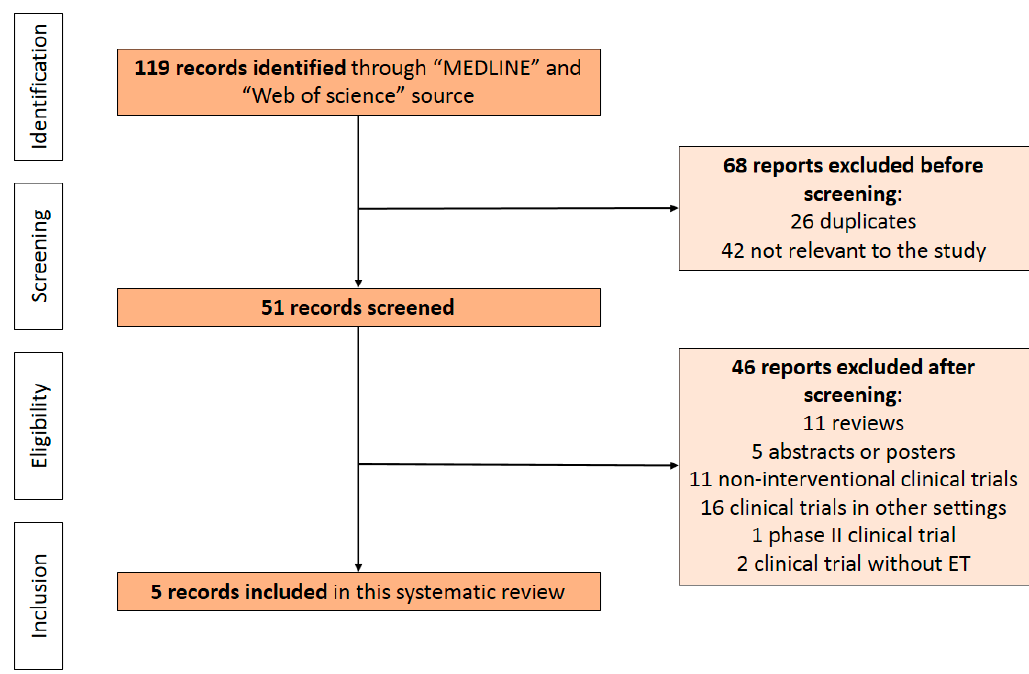
Figure 1. PRISMA flowchart summarizing the process to identify eligible studies.